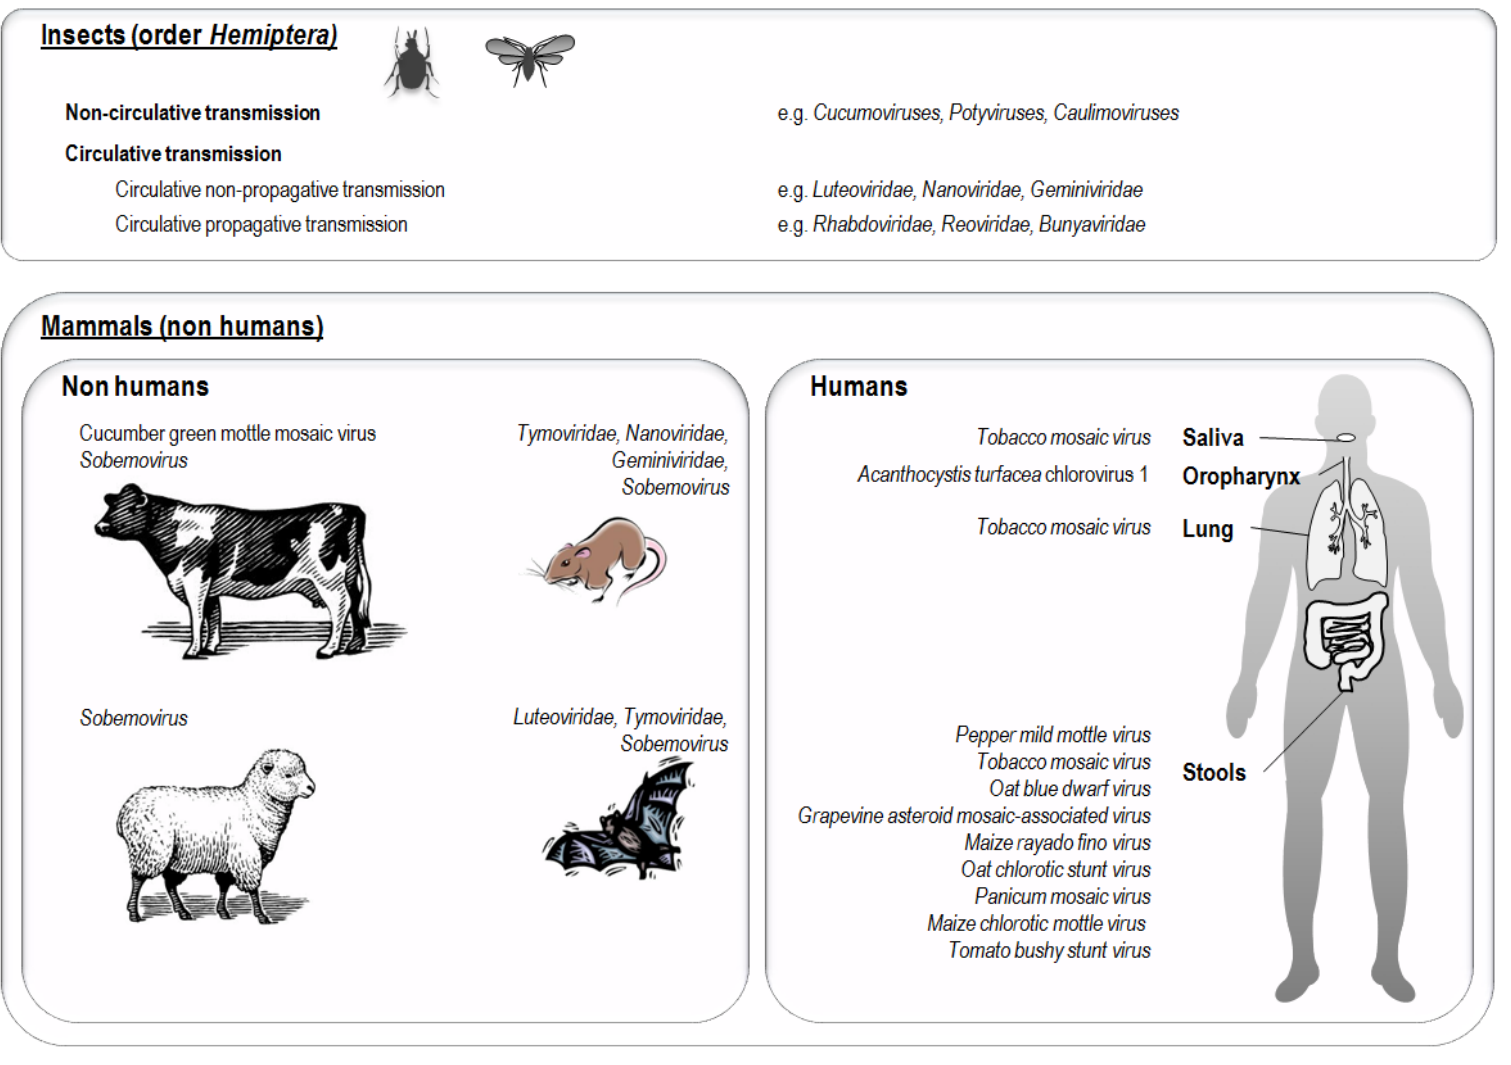
Figure 3. Detection of plant viruses in insects and mammals including